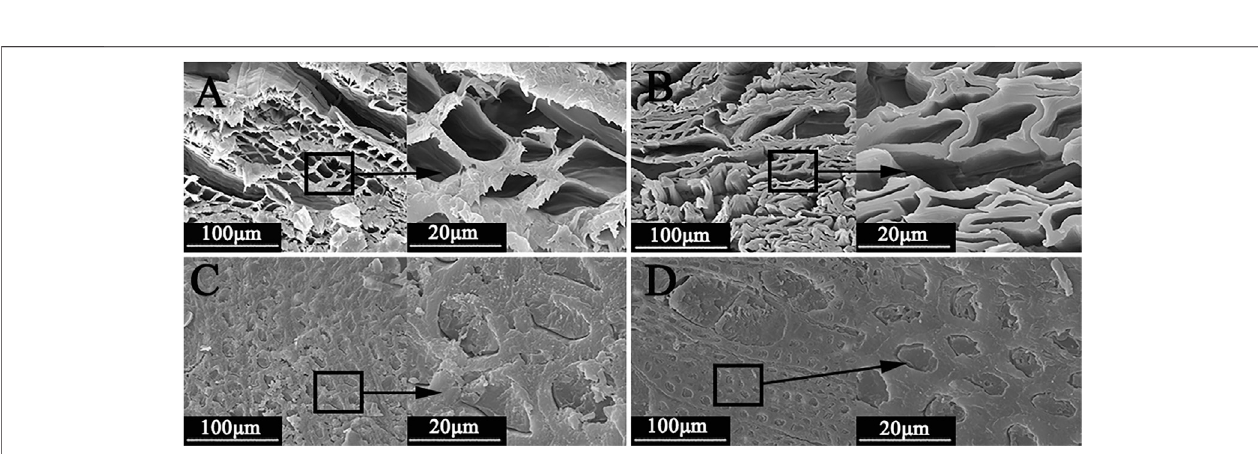
FIGURE 5 | SEM image of poplar with thickness of 1.5 mm and 2.5 mm after deligni fi cation and transparency treatment ( A . DW-C; B . DW-D; C .TW-C; D . TW-C).